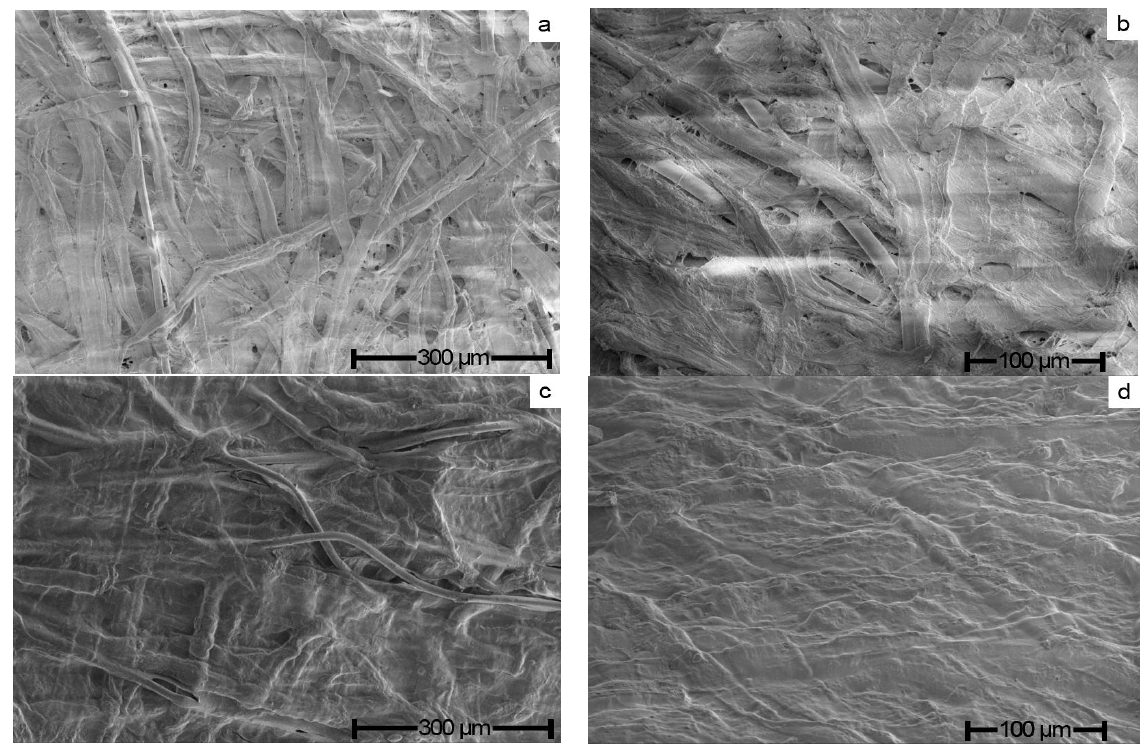
Figure 4. Morphology of the original paper (sample no. 1) ( a , b ) and modified with NMMO ( c , d ) .